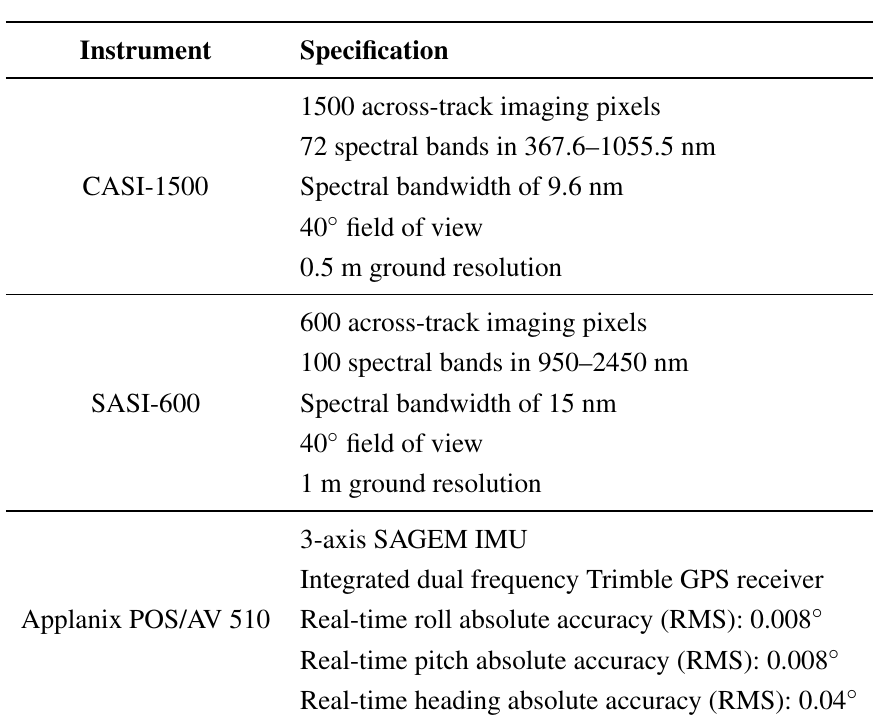
Table 1. Sensor acquisition